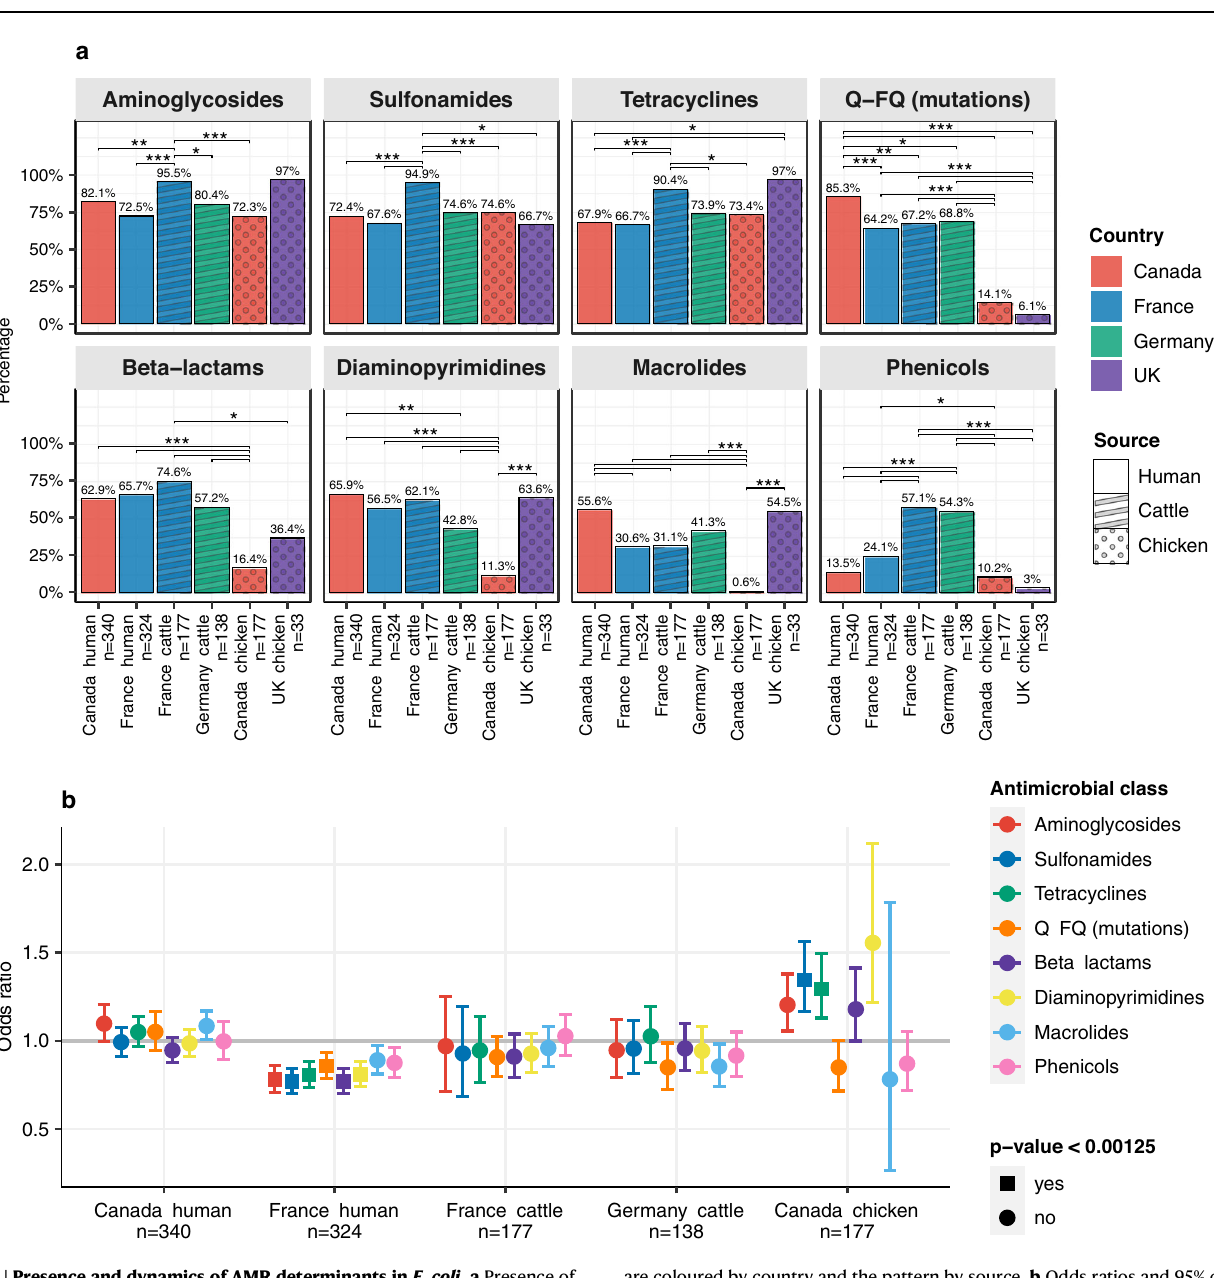
Fig. 3 | Presence and dynamics of AMR determinants in E. coli . a Presence of resistance determinants by antimicrobial class and compartment (country+ source) for n =1189 E. coli isolates. Two-sided Fisher ’ s Exact Test was used to comparetheproportionofAMRclassbetweencompartments,andthesigni fi cance levelsareindicatedwithasterisks:* p <0.01,** p <0.001and*** p <0.0001.Thebars